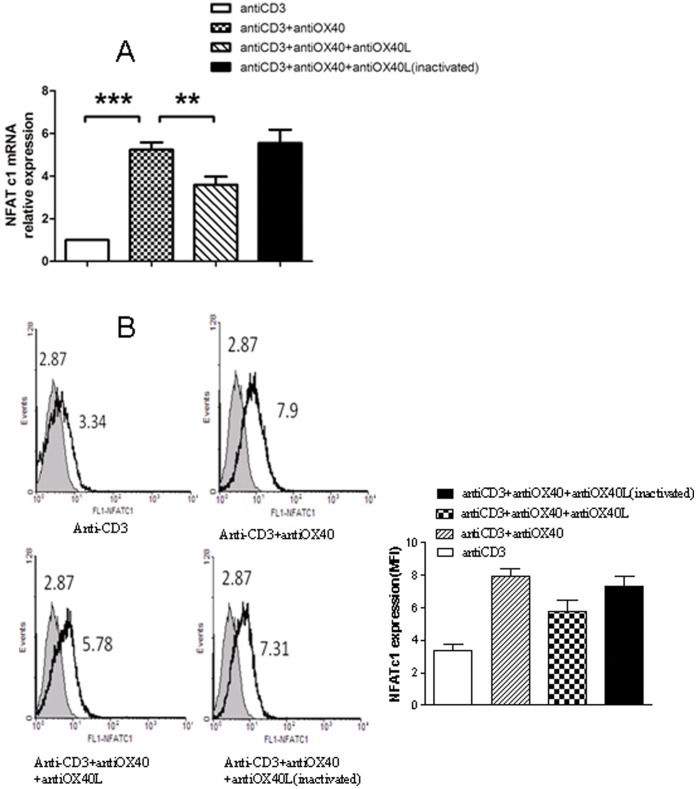
The expression of NFATc1 in lymphocytes by Real-Time PCR (A) and FCM (B).**, *** represent p<0.01 and p<0.001, respectively.